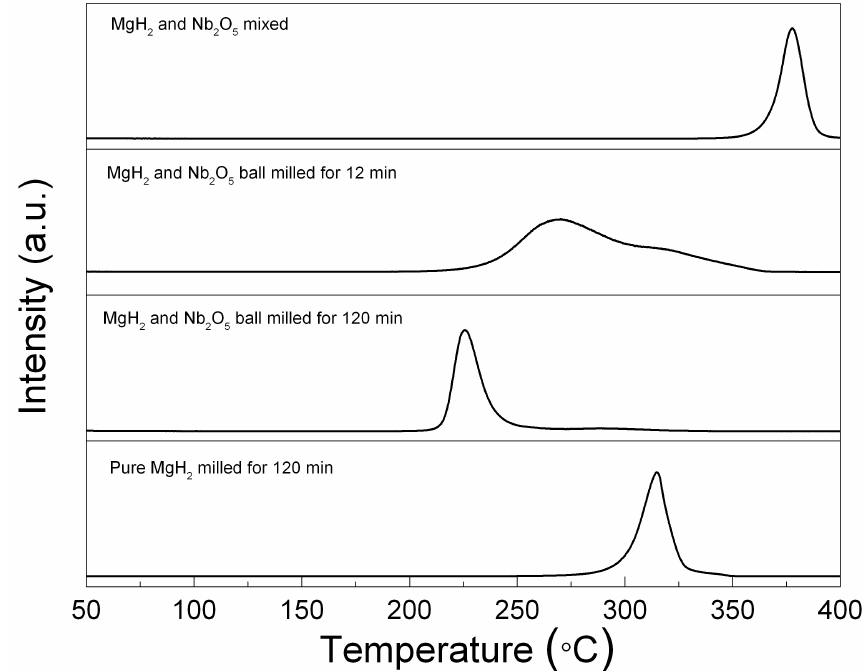
Figure 1. Profiles of TDS of hydrogen for the hand mixed and ball-milled